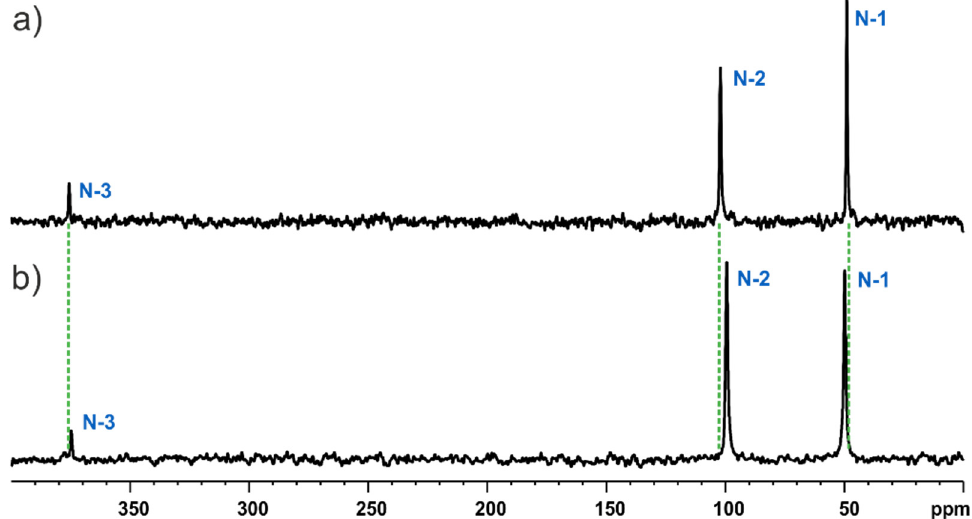
Figure 10. 15 N CP MAS NMR spectra of MBS recorded at a spinning rate of 12 kHz ( a ) and 25 kHz ( b ) at an ambient temperature. Asterisks indicated spinning sidebands.